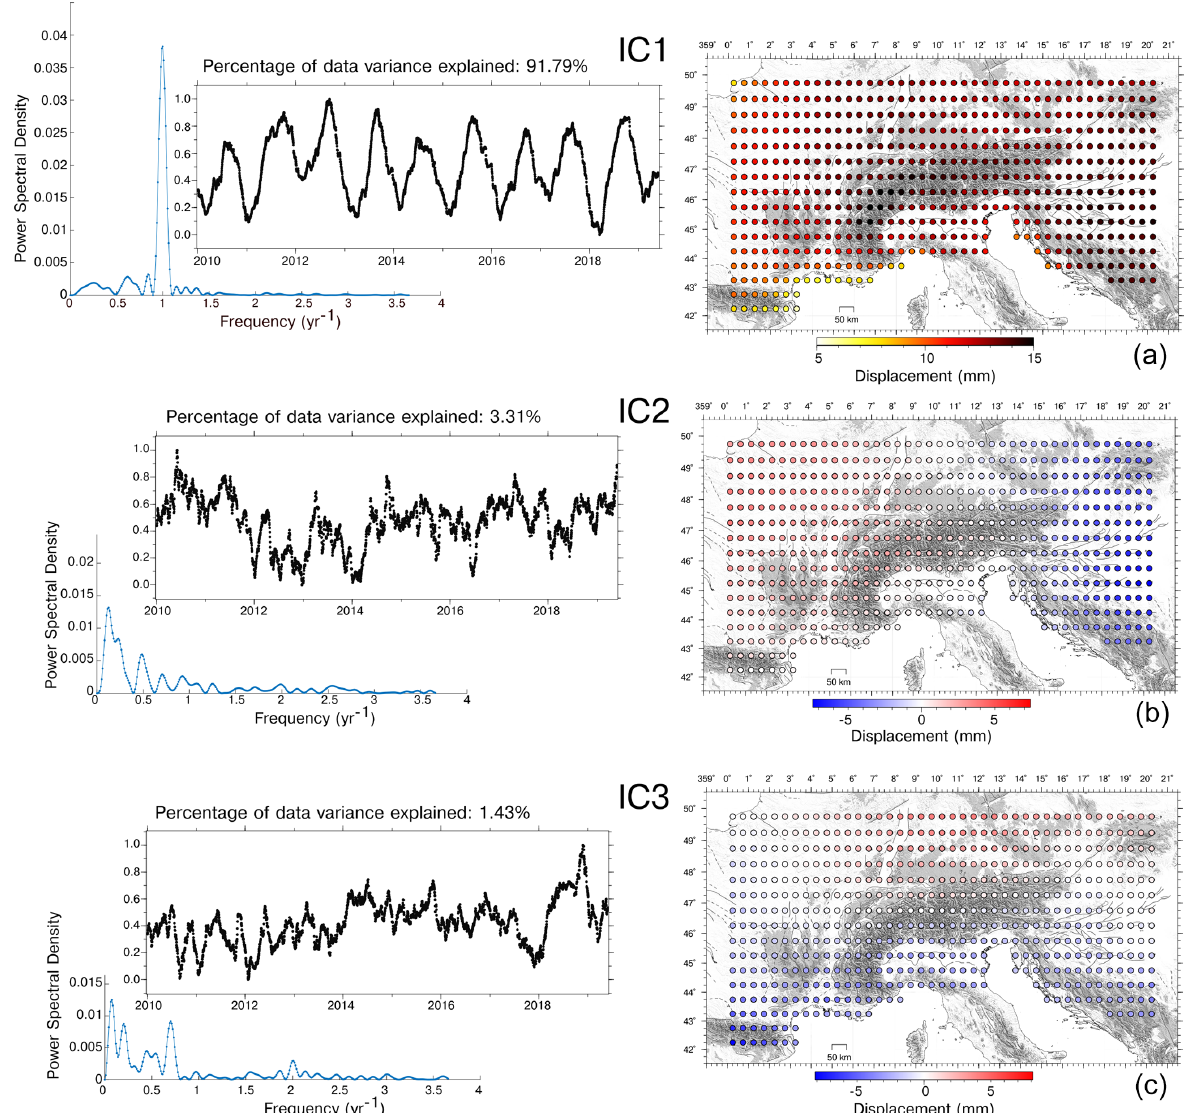
Figure 5. Temporal evolution, power spectral density and spatial response of IC1, IC2 and IC3 of the HYDL model.